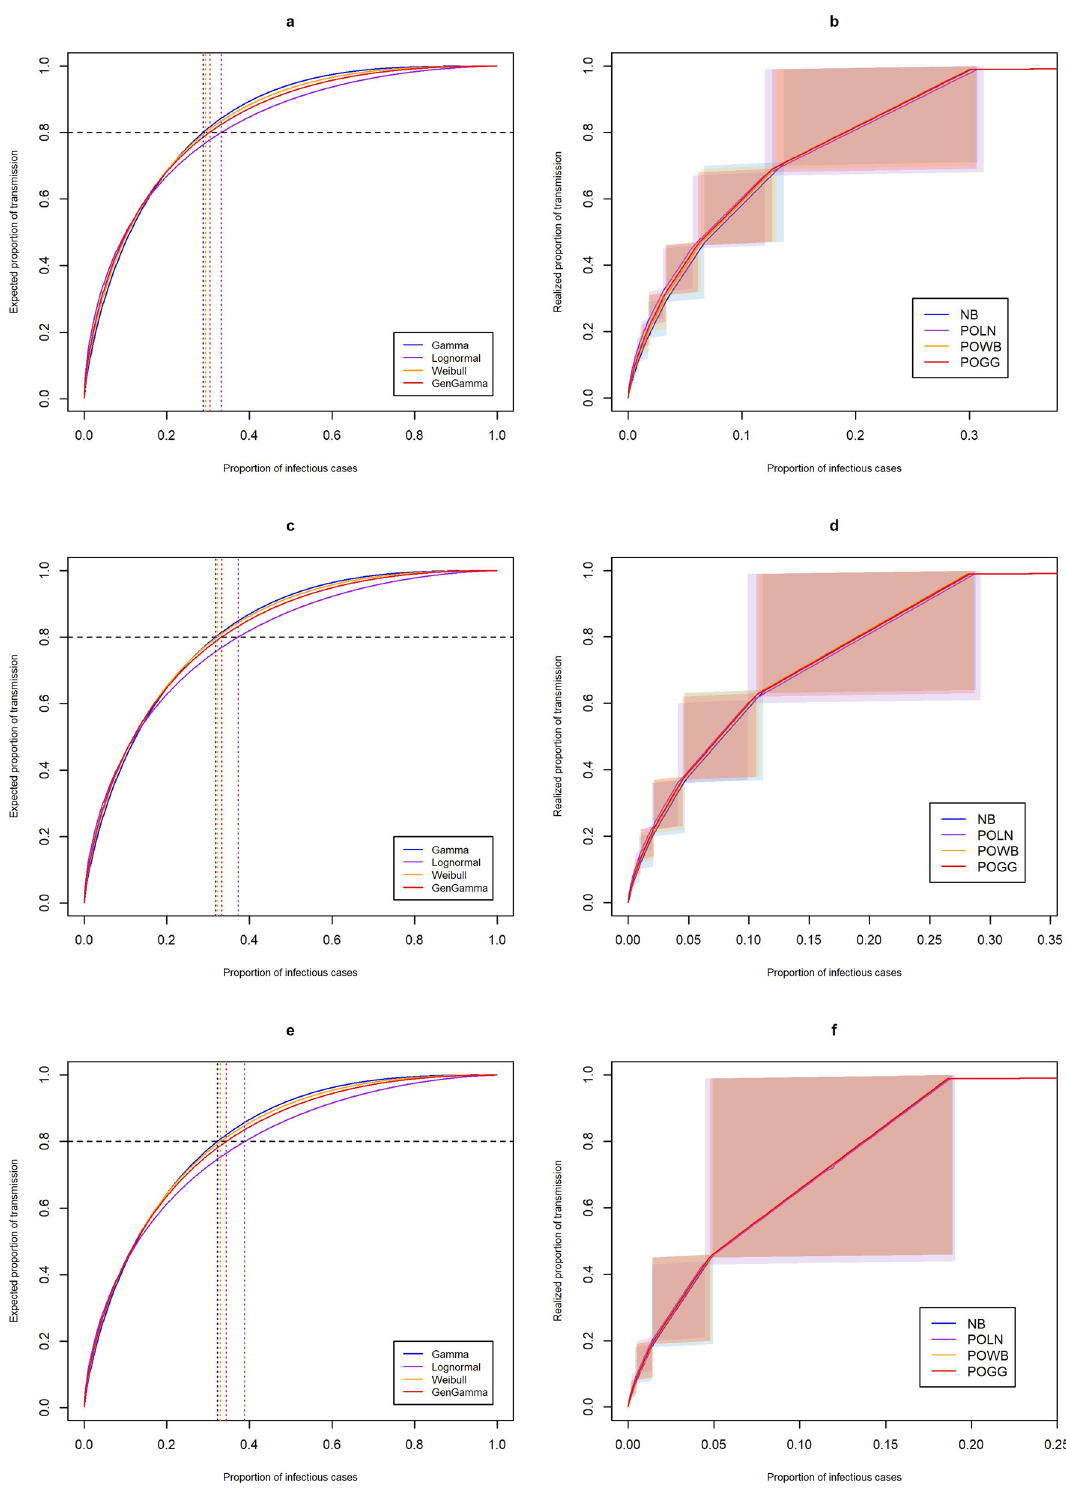
Figure 2. Proportion of most infectious cases responsible for a certain proportion of transmission, based on estimates from (a,b) Hong Kong, (c,d) India, and (e,f) Rwanda. Proportions are obtained based on the distribution of the individual reproduction number (left), and based on the complete offspring distribution (right). The shaded areas in the right panels represent the range surrounding specific proportions when considering the discrete nature of the realized offspring distributions (see Supplementary